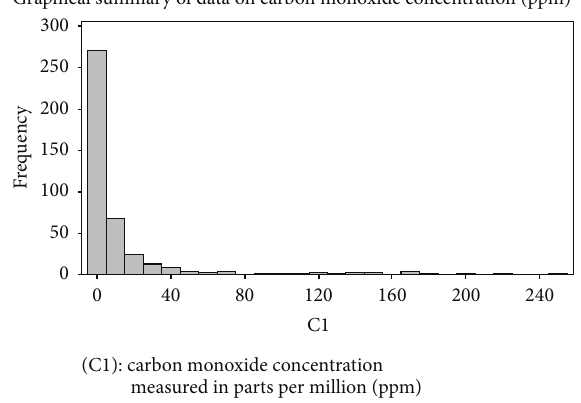
Figure 1: Histogram of data on carbon monoxide